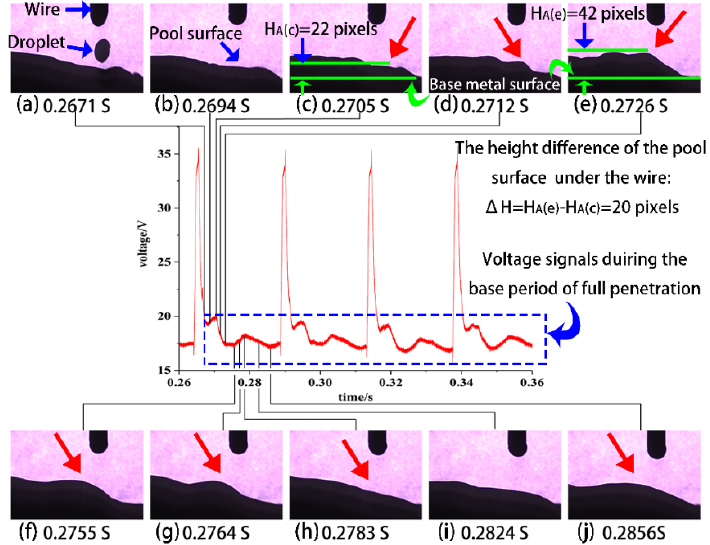
Figure 4. Combination of voltage signal waveform and fully penetrated weld pool oscillation process. High-speed photographs of weld pool at di ff erent times:( a )–( j ). (welding travel speed: 13.75 cm/min).